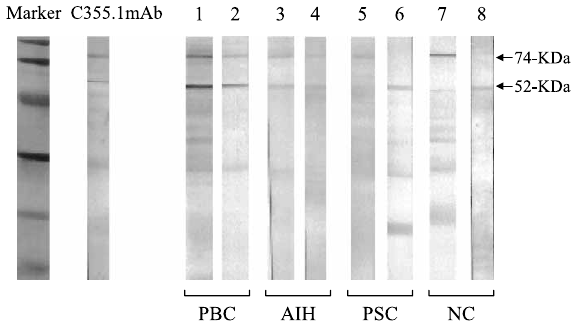
Figure 2. Representative IB pattern against E. coli DH5 alpha lysate overexpressing human PDC-E2 showing the 74 and 52kDa reacting proteins. Results obtained with the murine anti-human PDC-E2 monoclonal antibody C355.1 (panel A), 2 anti-PDC-E2- positive PBC sera (lanes 1 and 2), 2 (AIH) sera (lanes 3 and 4), 2 PSC sera (lanes 5 and 6), and 2 NC sera (lanes 7 and 8) are depicted (panel B). Reactivities against the 74 (lanes 1–5 and 7) and 54kDa (lanes 1–4, 6 and 8) proteins are